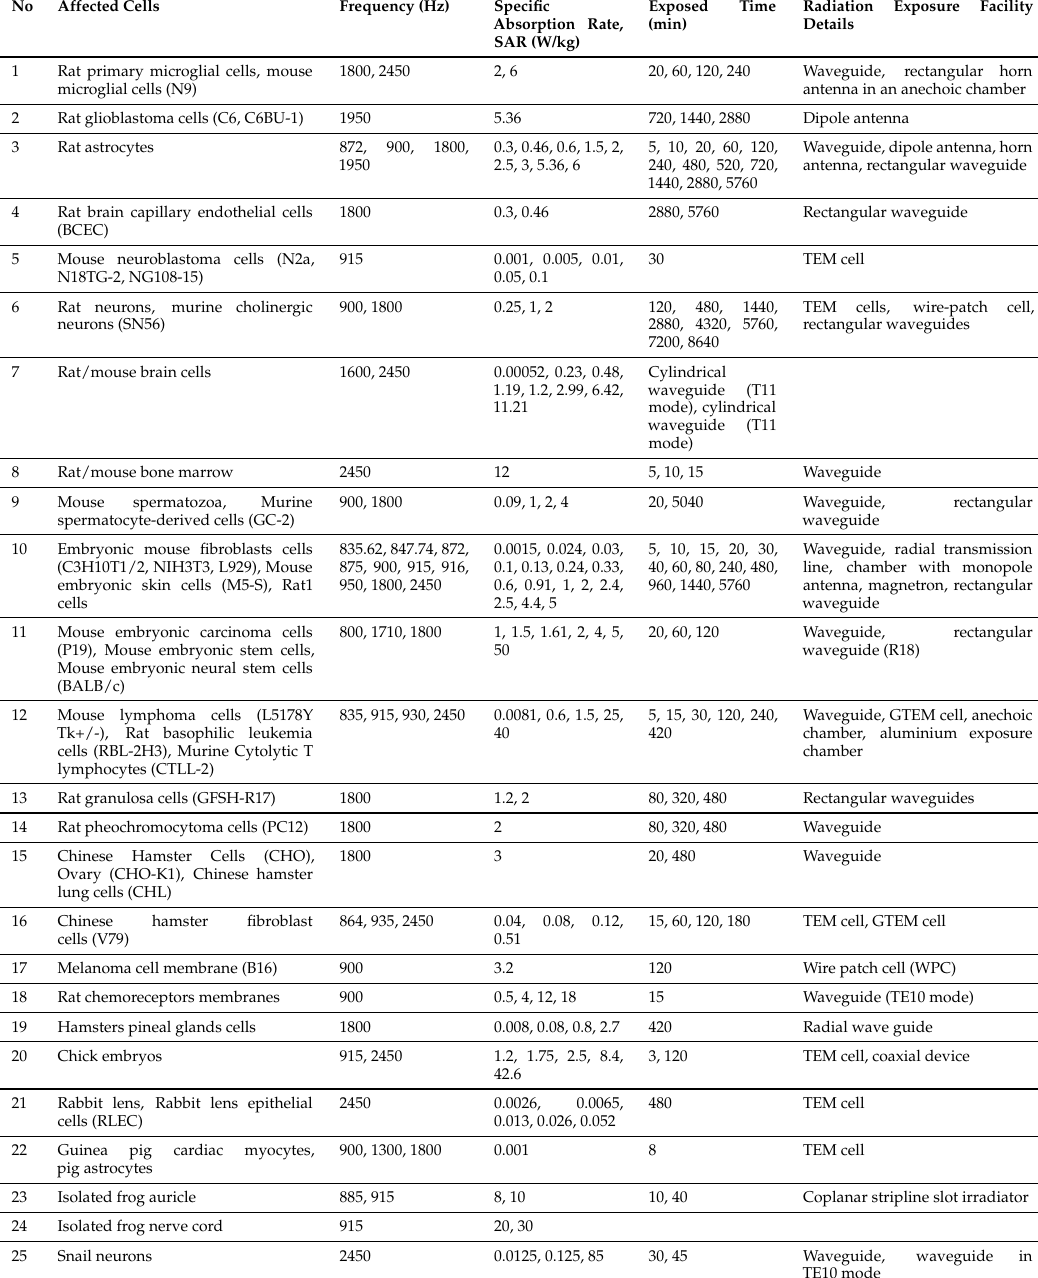
Table 4. An overview of the utilized laboratory experiments that provided a positive association (cellular response—presence) between weak RF-EMF and for animal